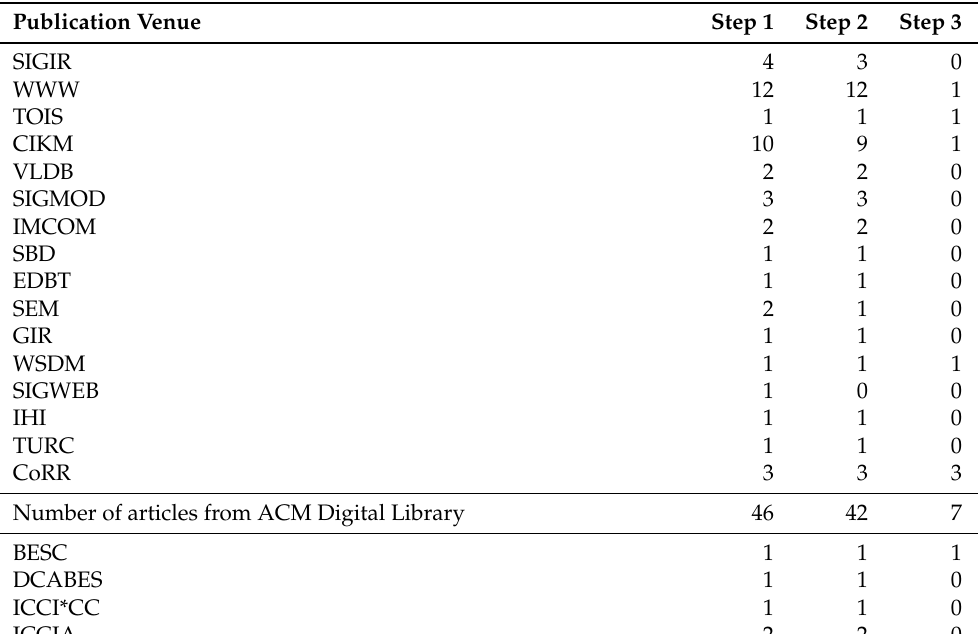
Table A3. The number of articles collected from ACM Digital Library, IEEE Xplore, and Science